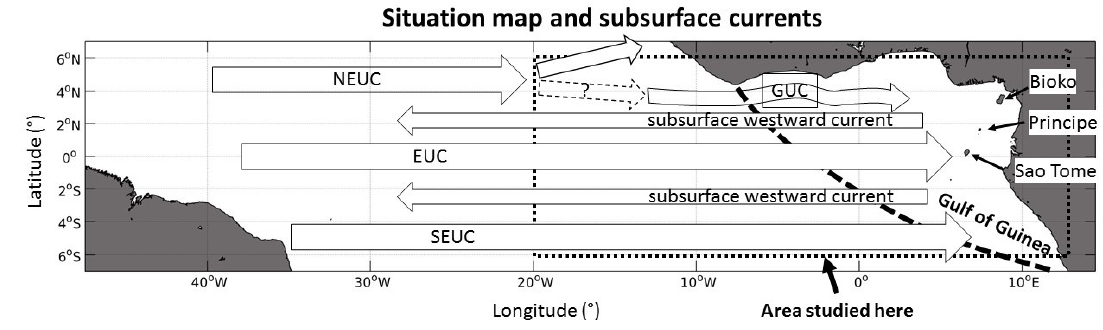
Figure 2. Situation map of the studied area. The position and name of the main subsurface currents discussed in the paper are indicated. The dotted box represents the area on which we